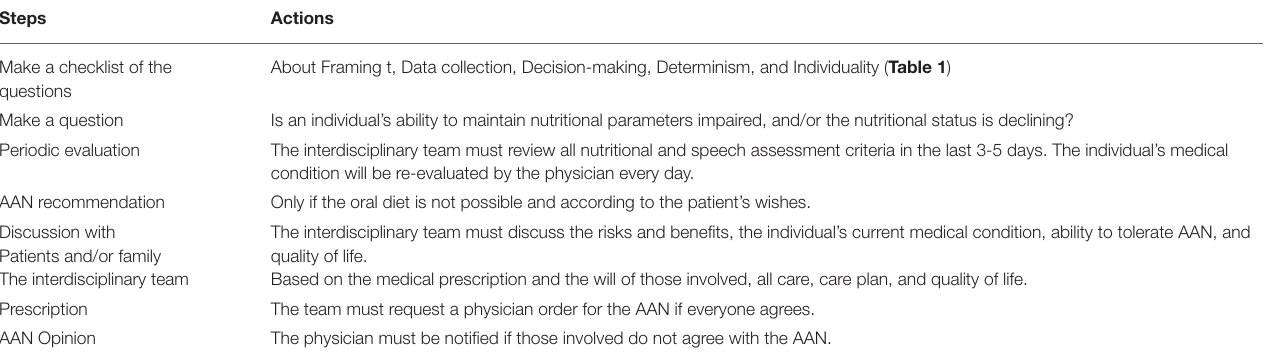
TABLE 3 | Seven steps for the interdisciplinary team to prescribe or not AAN with ethics and clinically based on scientific evidence, nutritional and bioethical consensus.